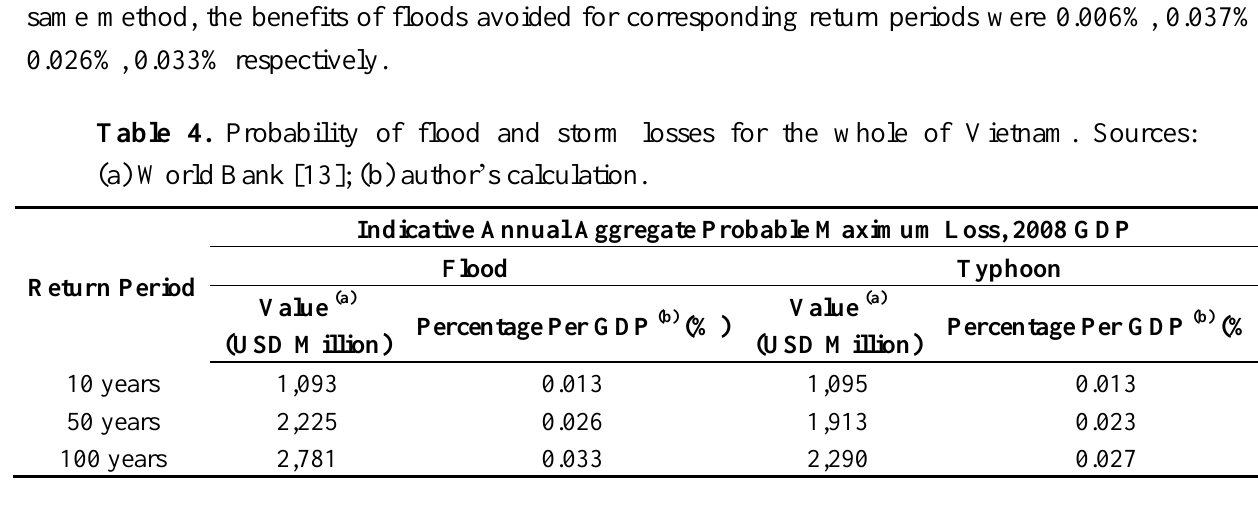
Table 5. Probability of flood and storm losses for the Mekong Delta. Source: CCFSC [12] and author’s calculation